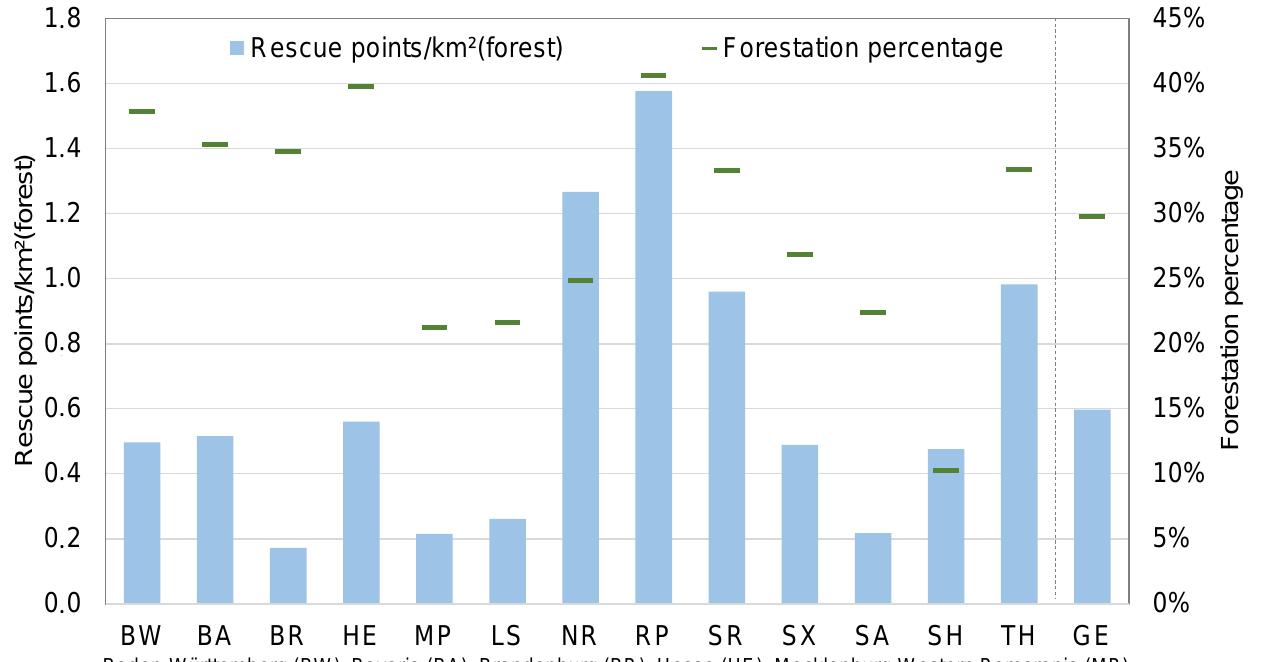
Figure X. Draw of existing rescue points (green cross) and calculated point density (browner, the denser) as an example at two German federal states: Baden-Würtemberg (left) and Bavaria (right)